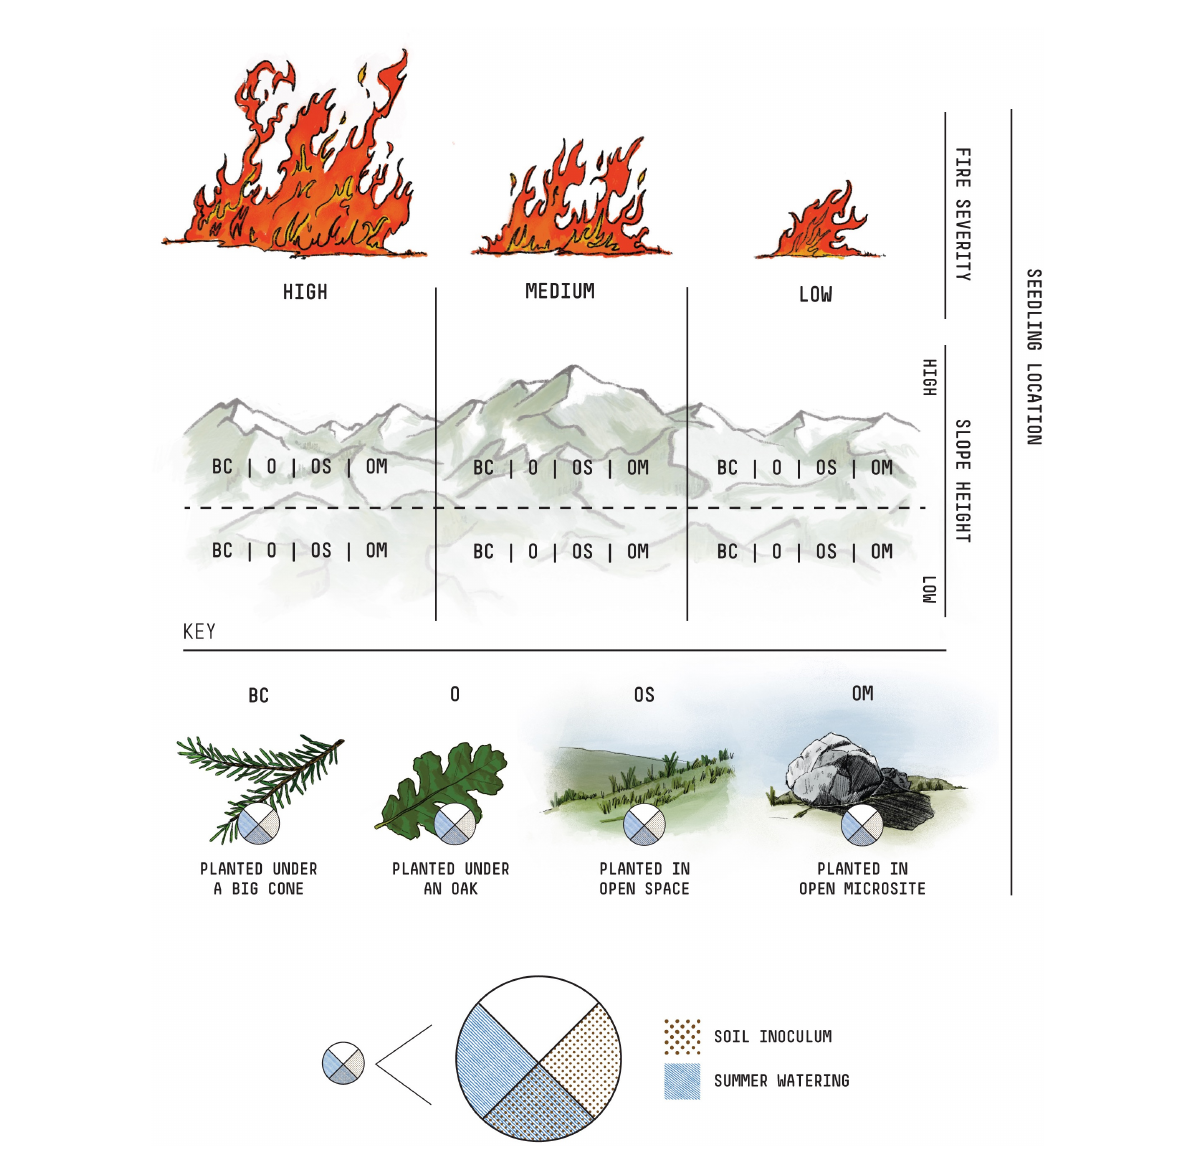
FIGURE2 Outplanting design. Breakdown of seedling planting locations across the landscape. Three fire severity levels were replicated twice in planting areas shown in Figure 1 . Within these areas, there were high and low elevation planting locations across which the microhabitat treatments were replicated (under bigcone Douglas-fir, under canyon live oak, in the open, and in the open with microsites). These sites (48 sites, 36 seedlings per site) were further broken down by inoculating half of the seedlings with live soil for mycorrhizal associates and watering half in June of the planting year such that nine seedlings had each of four combinations of soil inoculum or not and watering or